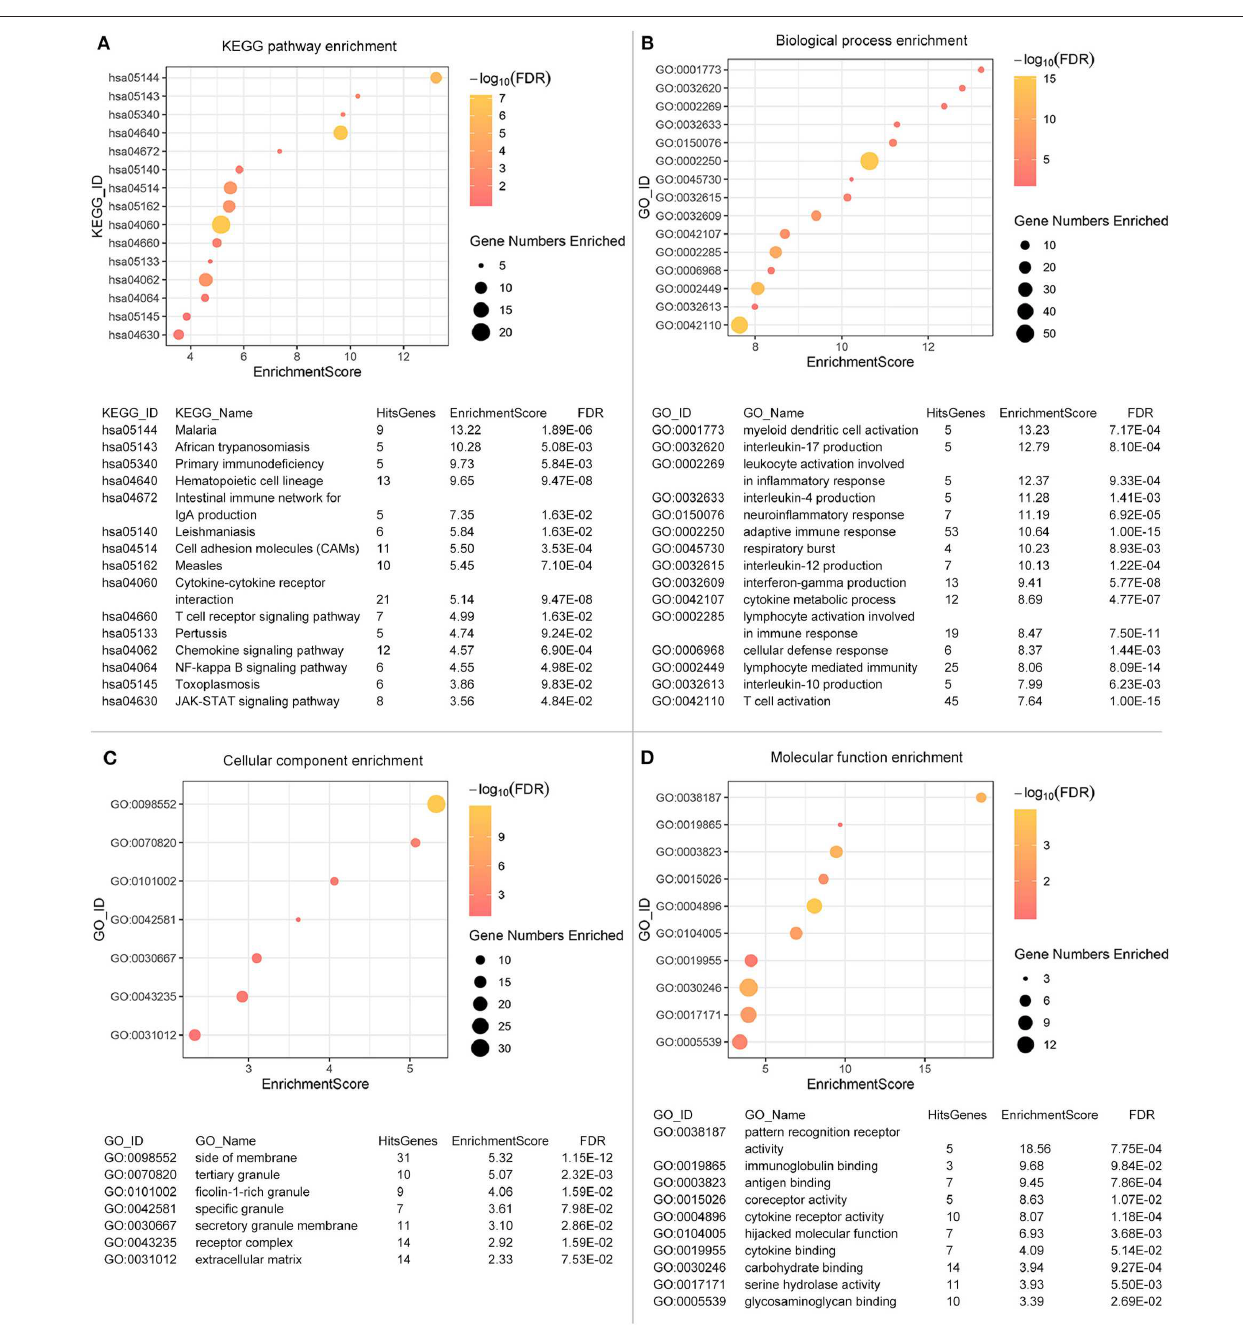
FIGURE 3 | Functional enrichments are operated. Fifteen biological processes (A) , ten molecular functions (B) , seven cellular components (C) and fifteen KEGG pathways (D) are illustrated. The color of the dots demonstrates -Log10 (FDR). Therefore, yellow dots shows greater FDR than red ones. The size of the dots indicates the number of genes enriched in the